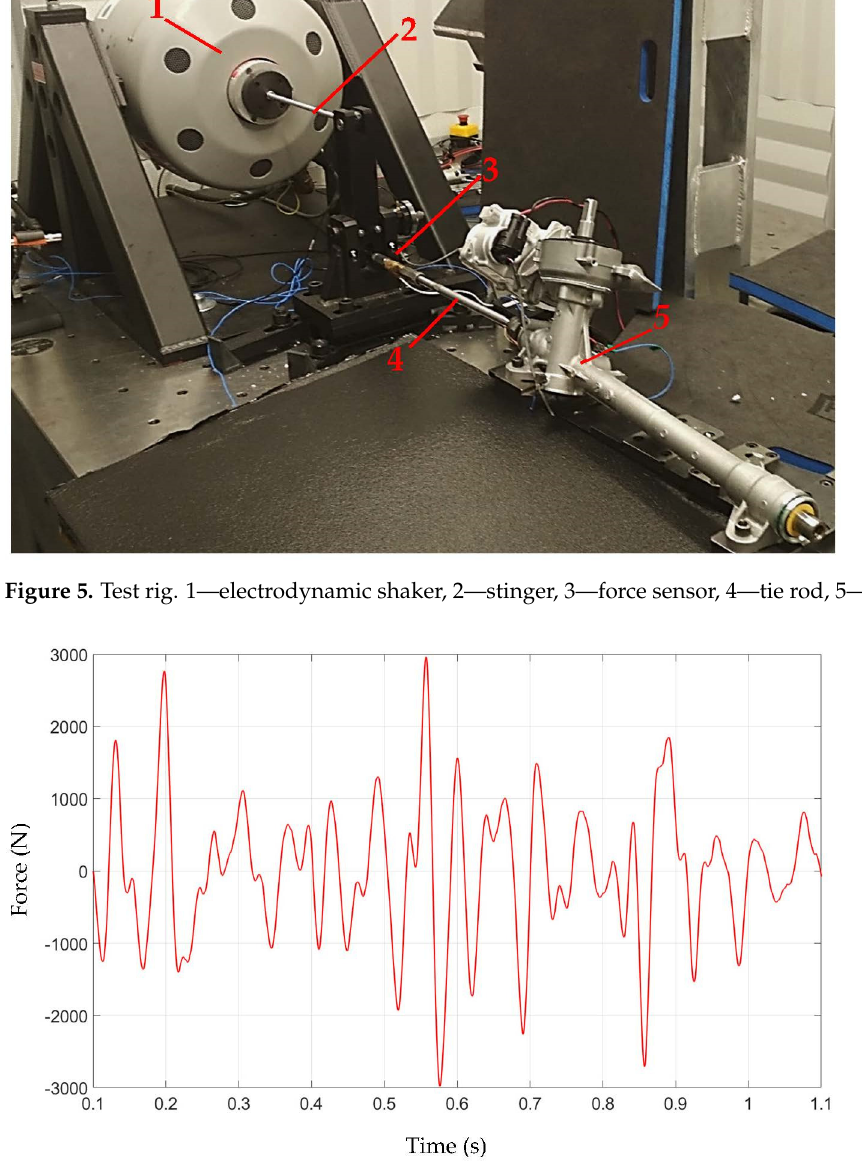
Figure 6. Excitation force time